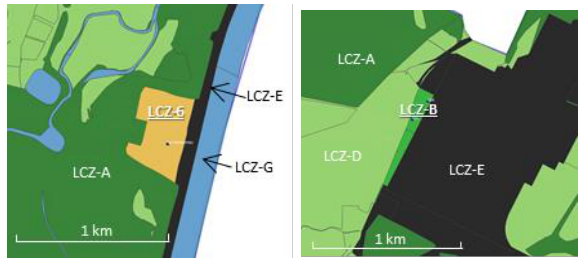
Figure 3. On the left: Position of LCZ-6 surrounded by LCZ-A, LCZ-E and LCZ-G. On the right: Position of LCZ-B surrounded by LCZ-E and LCZ-D.